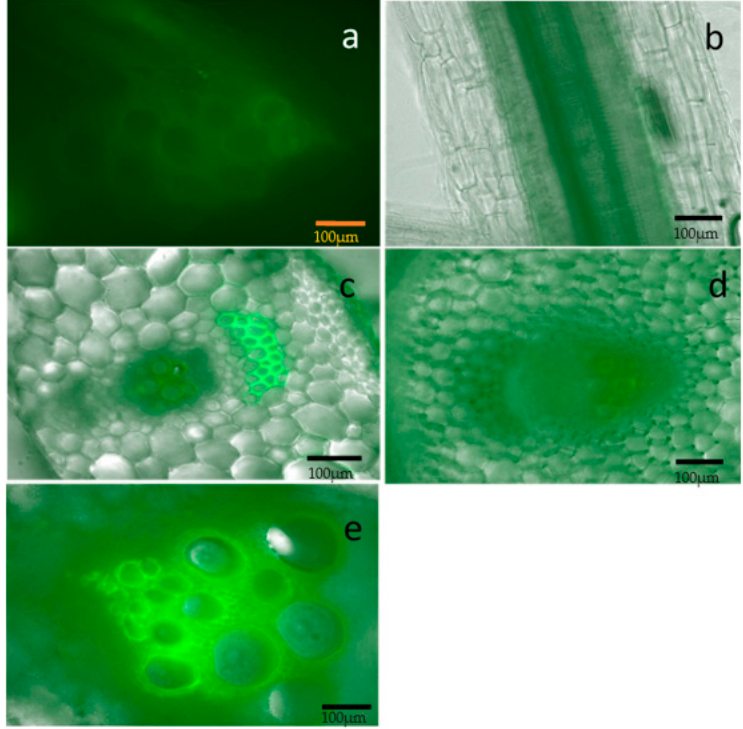
Figure 2. Localization of GFP bacteria in tissues of resistant melon line Ames 13299 at 21 days post inoculation. ( a ): Micrograph of a cross-section of primary root under fluorescence microscope showing GFP-labeled bacteria concentrated in the vascular system. ( b – e ): Overlay image of bright field and GFP fluorescence signal of ( b ): secondary root showing the concentration of bacteria in the cortical tissues, ( c ): inoculated leaf petiole, ( d ): petiole topmost leaf at 188 cm above the inoculated leaf and ( e ): stem at 15 cm below inoculated leaf. The presence of bacteria is indicated by the fluorescence. Scale bars = 100 µm.